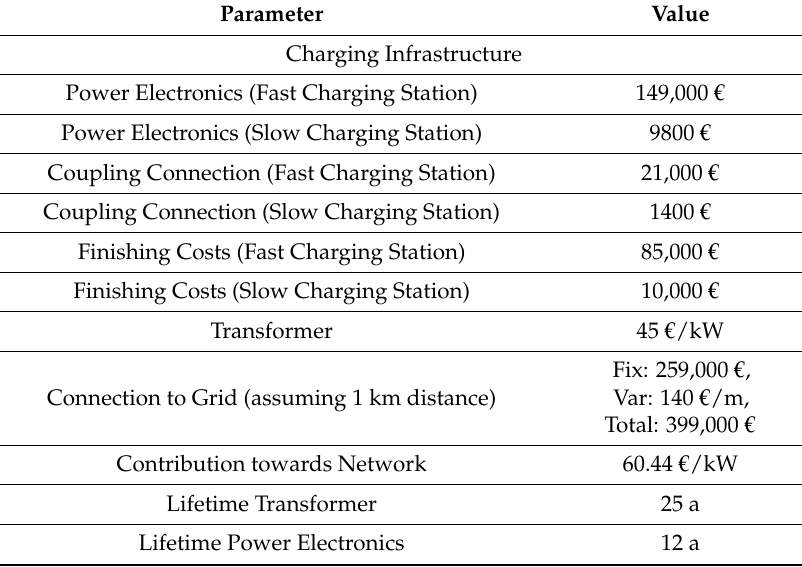
Table A2. Costs parameters for charging infrastructure used in LCC calculation. The source for the costs parameters in this table is private communication with manufacturers, who want to stay anonymous [43].